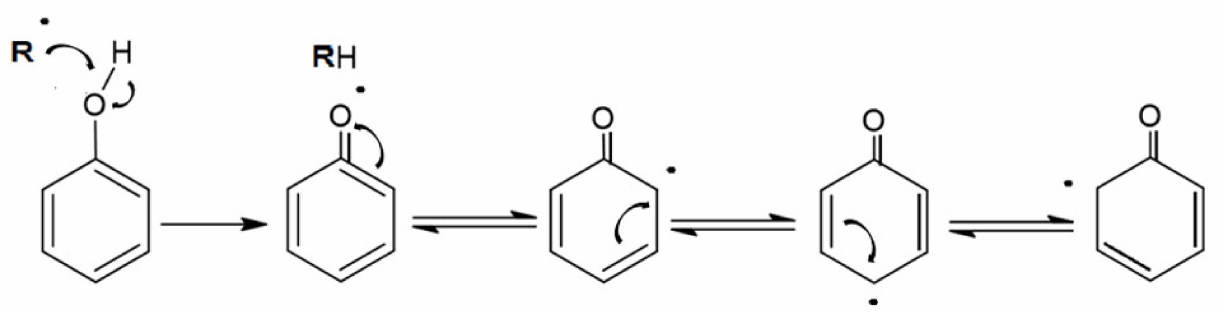
Figure 2. Illustration of the delocalization of